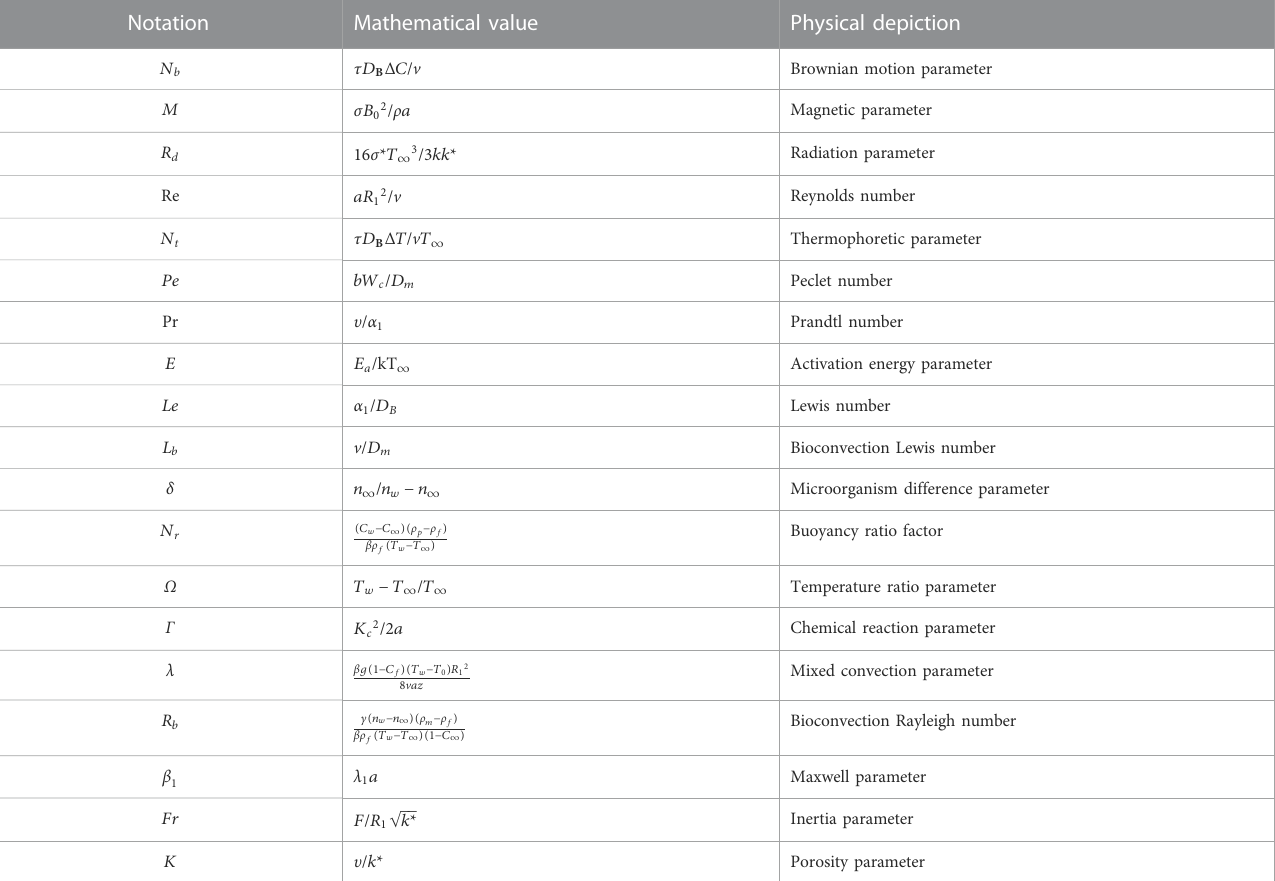
TABLE 1 Depiction of substantial